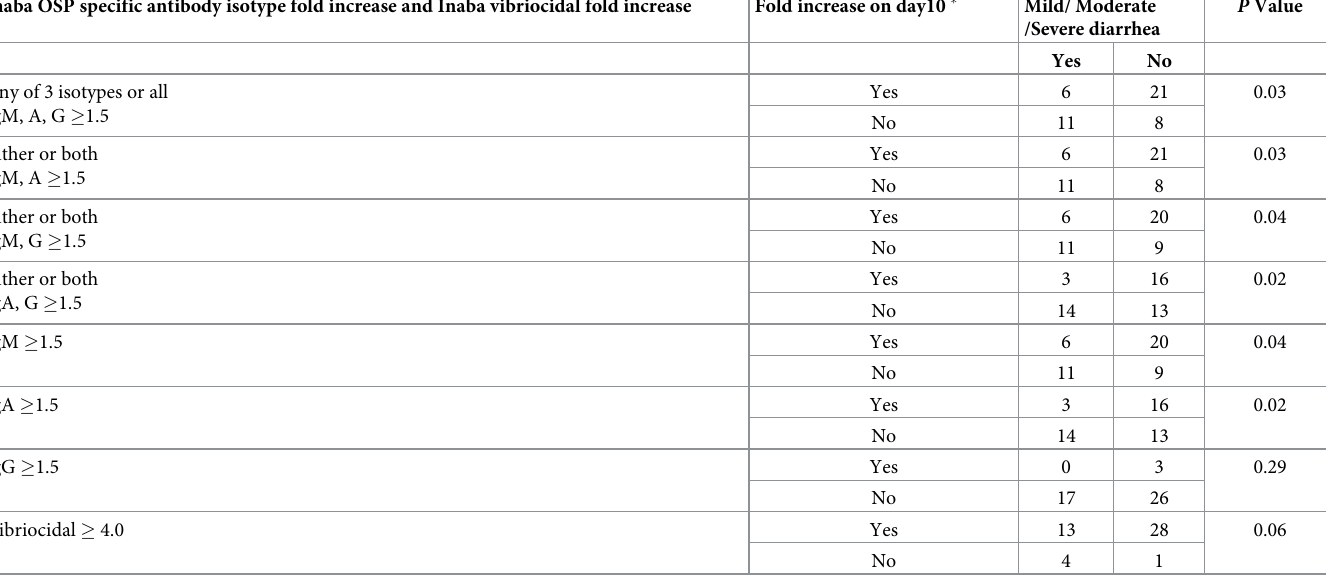
Table 4. Serum Inaba OSP-specific antibody isotype fold increase ( (cid:21) 1.5) and Inaba-specific vibriocidal fold increase ( (cid:21) 4) on day 10 following vaccination as a pre- dictor of protection against development of mild, moderate or severe diarrhea following subsequent challenge. Inaba OSP specific antibody isotype fold increase and Inaba vibriocidal fold increase Fold increase on day10